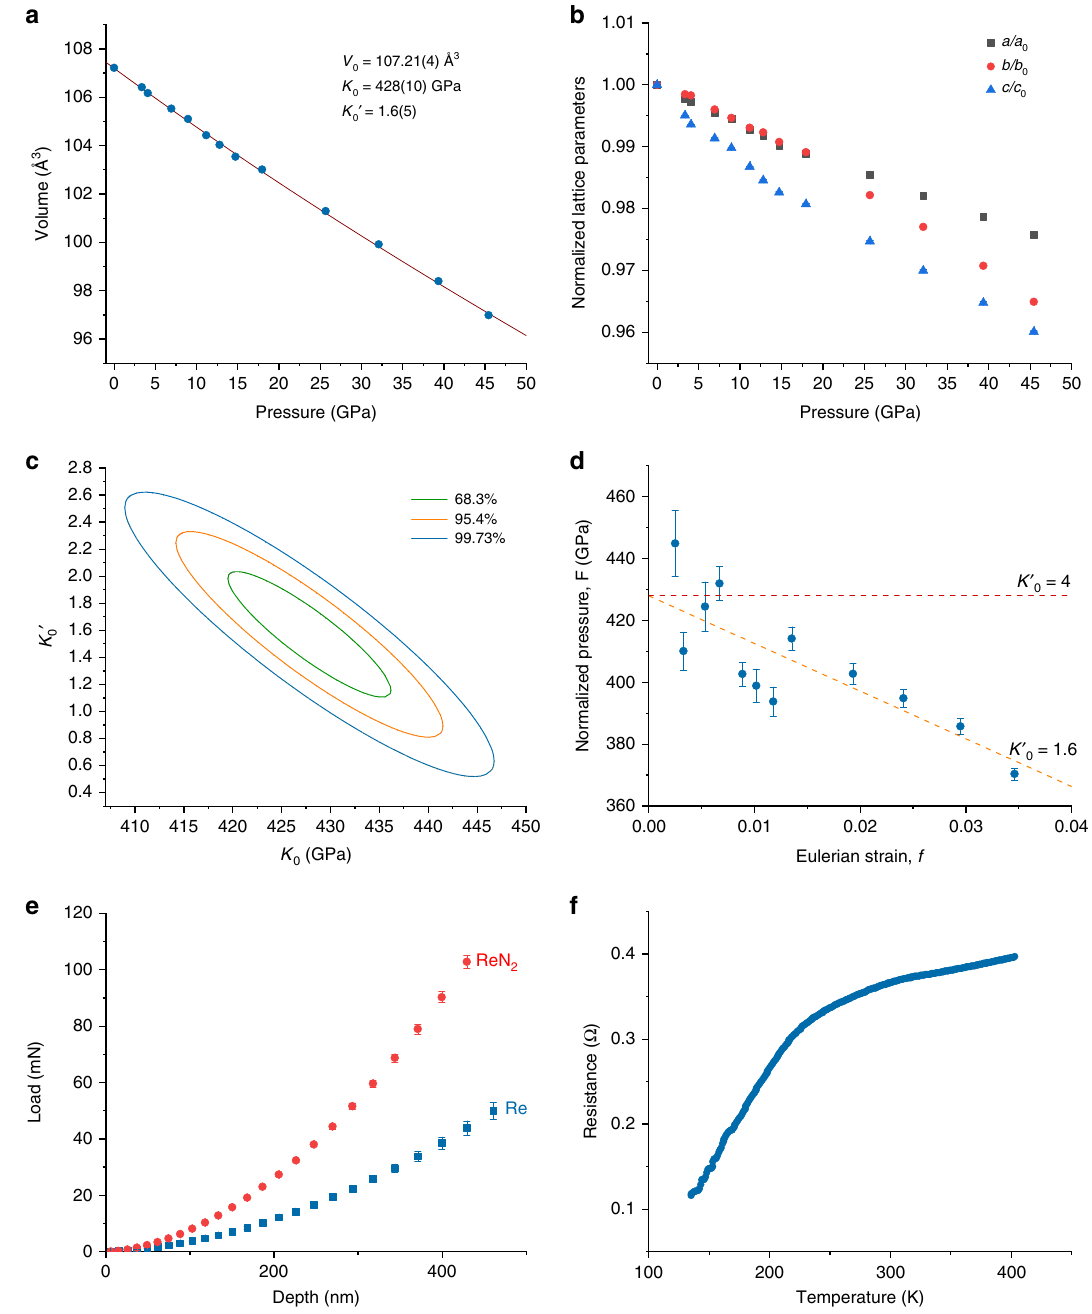
Fig. 2 Physical propeties of Re 2 (N 2 )(N) 2 . a Pressure-dependence of the unit-cell volume of ReN 2 . The solid line shows the fi t of the third- order Birch – Murnaghan EoS to the experimental data. b Normalized lattice parameters of ReN 2 . Black squares a / a 0 , red circles – b / b 0 , blue triangles – c / c 0 , where a b c 0 , 0 , 0 are the lattice parameters at ambient conditions. c Plot of the correlated values of 99.73%, respectively. d An F-f plot based on Birch – Murnaghan EoS. Dashed lines indicate expected behavior of data points for certain K 0 ′ values. Uncertainties were calculated by propagation of experimental uncertainties in the unit cell volume. e Averaged indentation load-displacement data for Re (blue squares) and for ReN 2 (red circles). The error bars correspond to the standard deviation between 16 single measurements at different locations. f Temperature dependence of the electrical resistance of the ReN 2 sample at ambient pressure. If error bars are not shown, they are smaller than the symbol